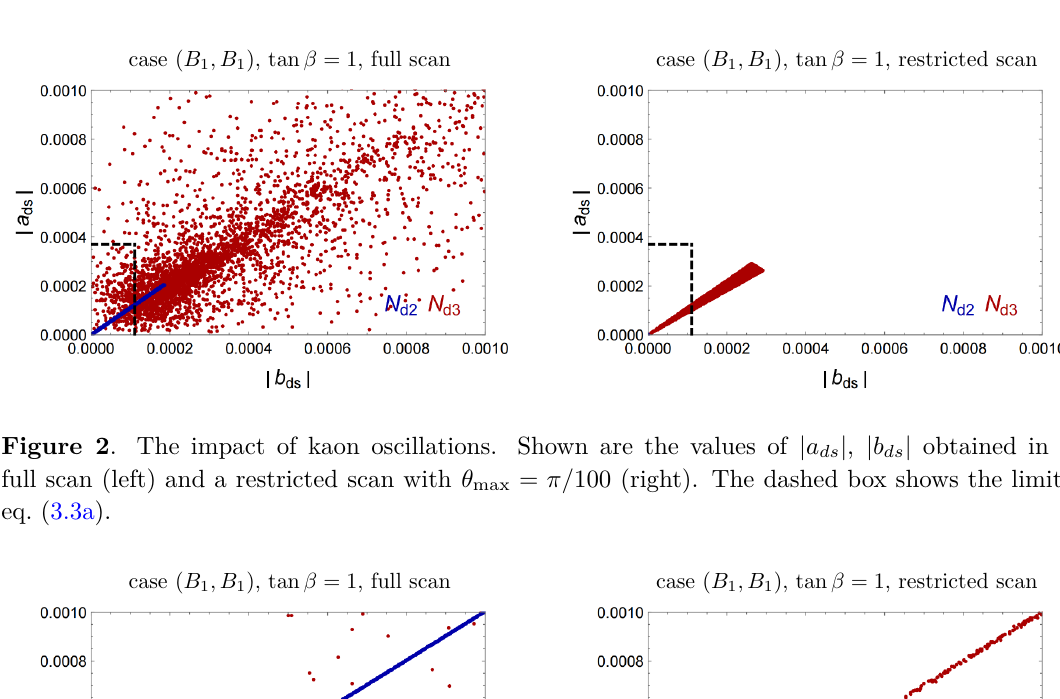
= π/ 100 (right). The dashed box shows the limits max